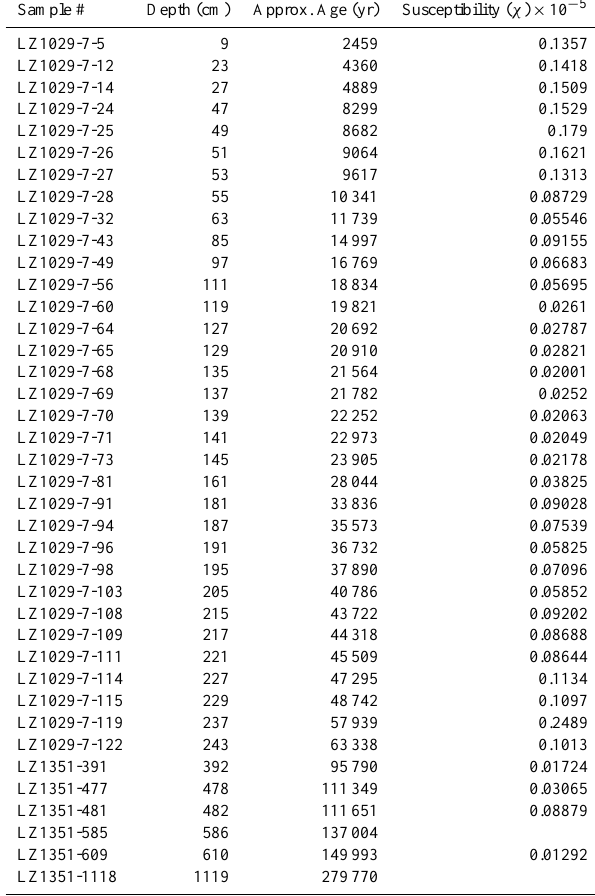
Table 1. Samples taken from LZ1029-7 and PG1351 for discrete susceptibility and other rock magnetic property